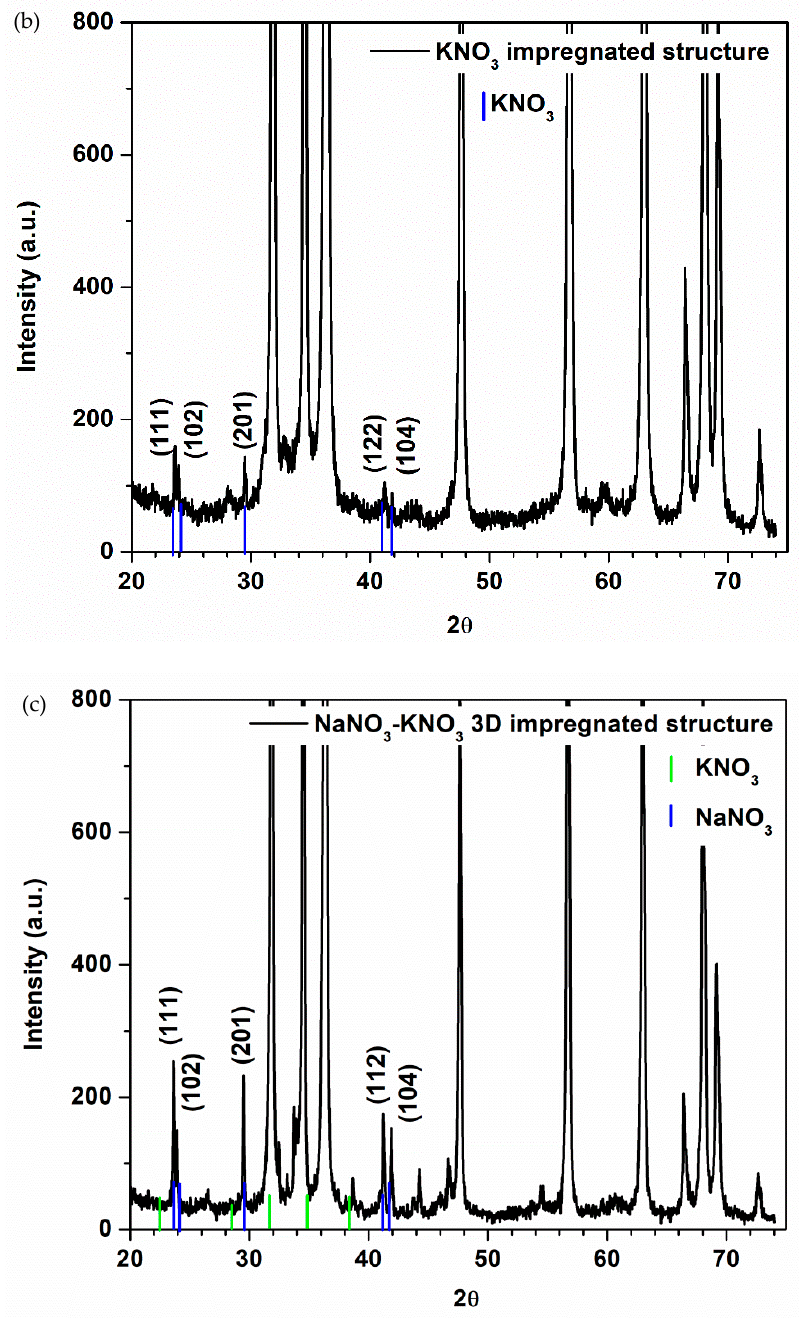
Figure 7. XRD patterns of ZnO-CNT-based 3D support structure impregnated with PCM salts: ( a ) NaNO 3, ( b ) KNO 3 and ( c ) NaNO 3 :KNO 3 .